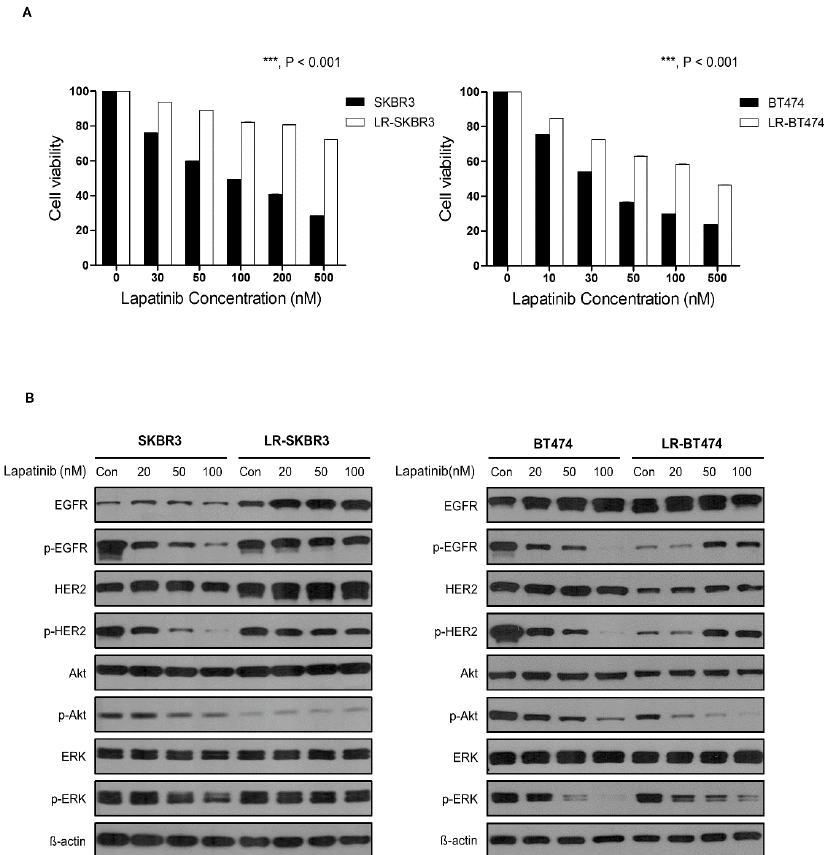
Figure 1. Establishment of lapatinib-acquired-resistant Human Epidermal growth factor Receptor 2 (HER2) ( + ) cell lines and biologic changes in HER2 downstream signaling. ( A ) Lapatinib was administered for 48 and 72 h at different concentrations in SKBR3, BT474, LR-SKBR3, and LR-BT474 cell lines and measured using MTT (3-[4,5-dimethylthiazol-2-yl]-2,5-diphenyltetrazolium) analysis. Results are expressed as percentage of viable cells from three independent experiments (mean ± SD) (***, p < 0.001). ( B ) Parental and lapatinib-resistant cell lines were treated with lapatinib at 20, 50, or 100 nM concentrations for 24 h. Western blot was performed using same amounts of protein. Protein